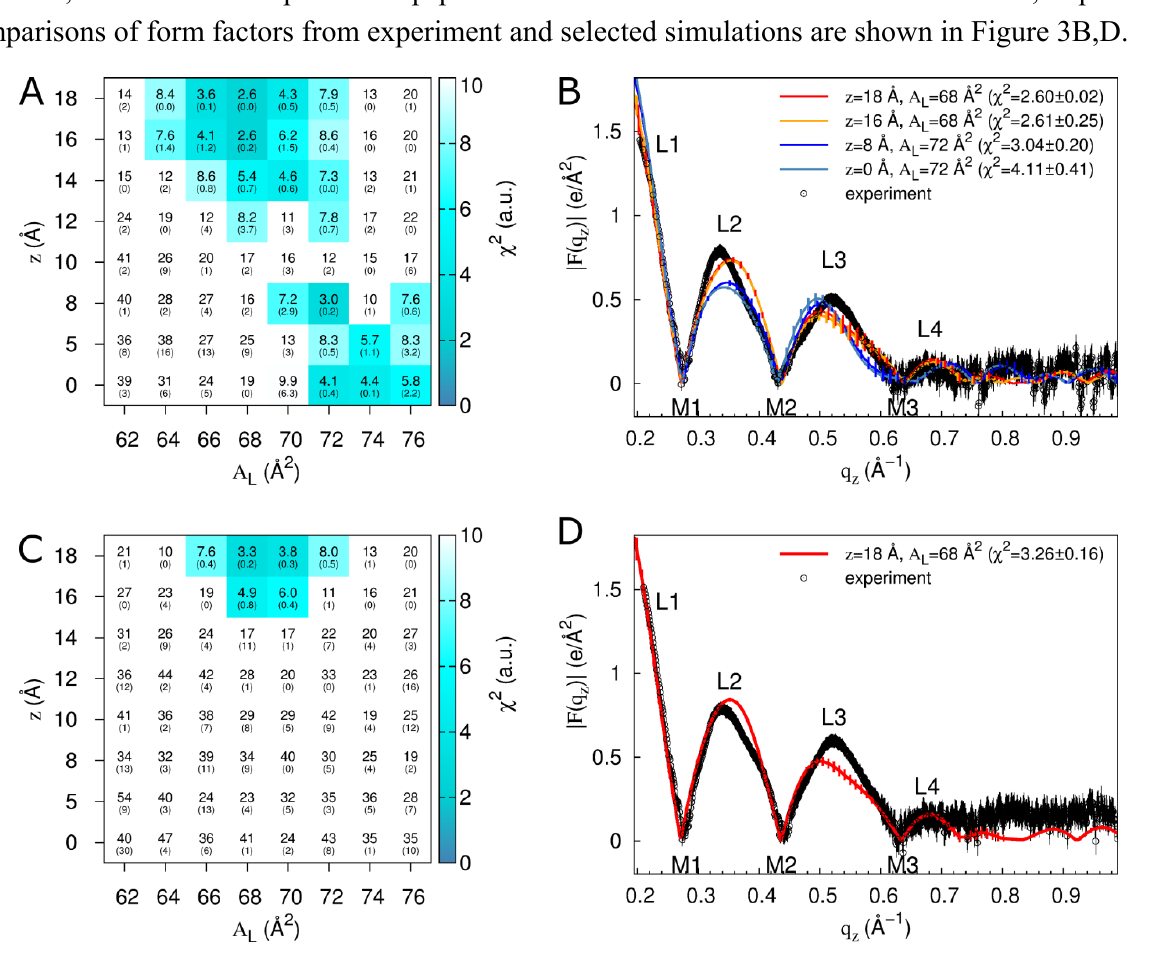
Figure 3. Fits of simulation to experiment for a systematic evaluation of z and A L in DOPC:DOPE (1:1). Data are from simulations with two ( A , B ) or four ( C , D ) molecules of Tat 47–57 (simulation mole fractions of 0.015 and 0.030, respectively; comparisons are to experimental data at mole fractions of 0.016 and 0.034, respectively). ( A , C ) Color and inset numbers represent χ 2 values (standard deviations of averages from repeat simulations in parentheses). ( B , D ) Selected form factors ( χ 2 values in parentheses). Out-of-plane scattering lobes (L) and minima (M) are numbered based on experimental data, which are averaged over two ( B ) and nine ( D ) experiments. Black vertical lines depict experimental error estimates (see Methods). Vertical lines on the simulation data depict standard deviations between two starting configurations. Experimental data in ( B) and ( D ) were scaled to the simulations at z = 18 Å, A L = 68 Å 2 (see